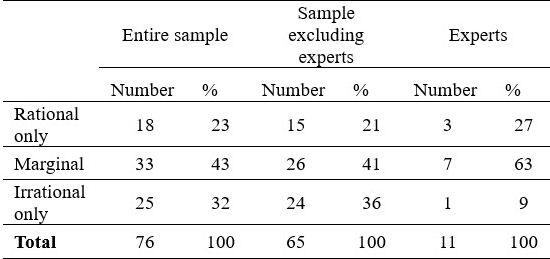
Table 3. Results of testees’ distribution for groups depending on the rationality of the adopted decisions